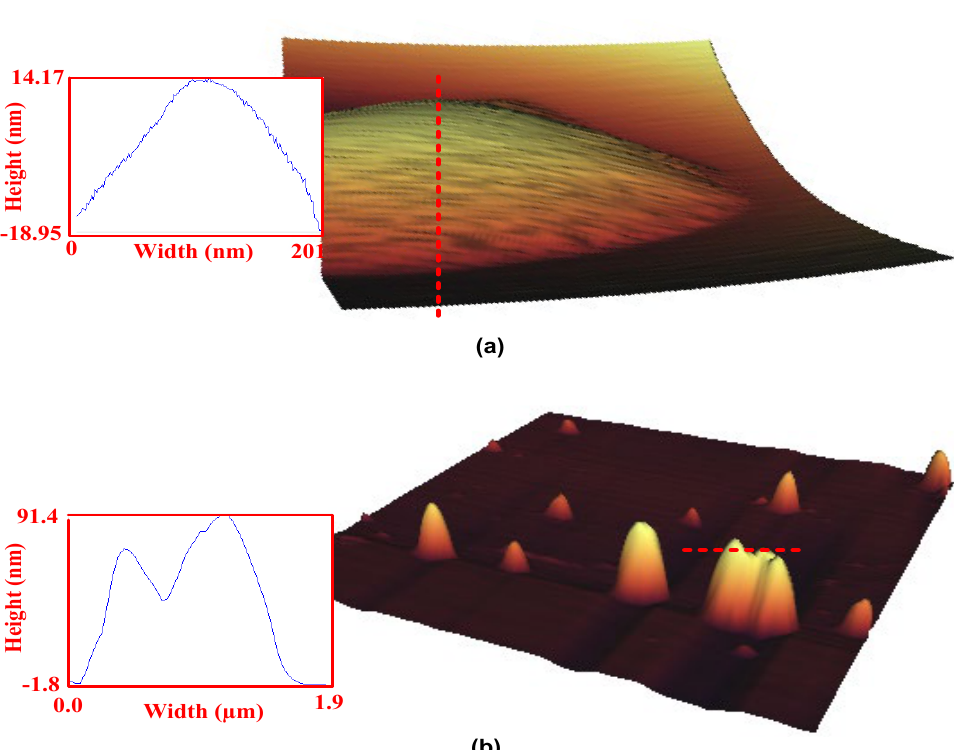
Figure 4. The AFM images of the dipicolinic-acid-imprinted polymers ( a ) and the non-imprinted ones ( b ). The surface topography was elucidated using curves of the density profiles along the red dotted lines. Reprinted with permission from [71].